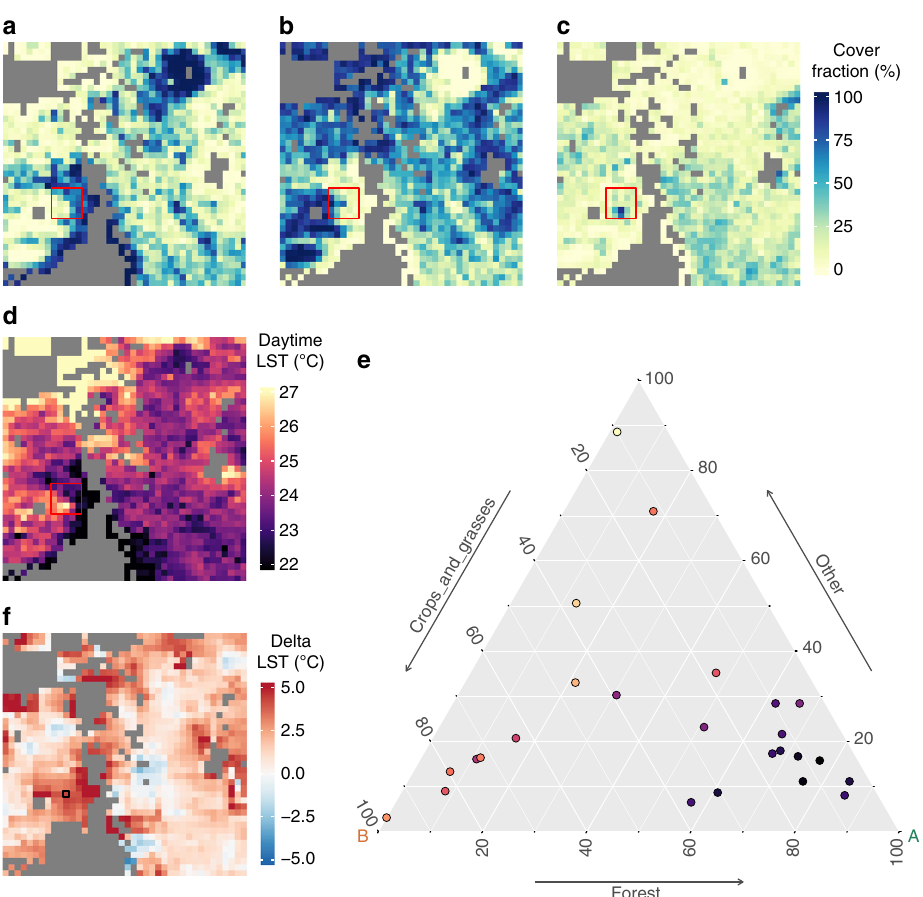
Fig. 7 Illustration of the methodology for retrieving the local biophysical signal associated to potential vegetation change. The input consists of vegetation cover fraction maps for different classes, in this case: forests ( a ), crops/grasses ( b ) and other ( c ); and the spatial variation of the target biophysical variable, here day-time land surface temperature (LST) ( d ). e Ternary diagram showing the values of the 25 pixels in the red boxes of a – c respectively plotted in the three axes. The colour of the points represents the corresponding values of the biophysical variable. The regression in the compositional space allows the estimation of LST at the vertices of the triangle: vertex A representing a full forest cover and vertex B representing 100% cover of crops/ grasses. The difference between these values is the estimated change in LST following a total change from forests to crops/grasses for the pixel in the centre of the 5 by 5 window. f The estimated change in LST for the transition from forests to crops/grasses for the entire region. Grey areas are masked out because of the topographical fi ltering or lack of co-occurrence of either forests or crops/grasses. The size of the pixels is 0.05° or ~5.5 km at the